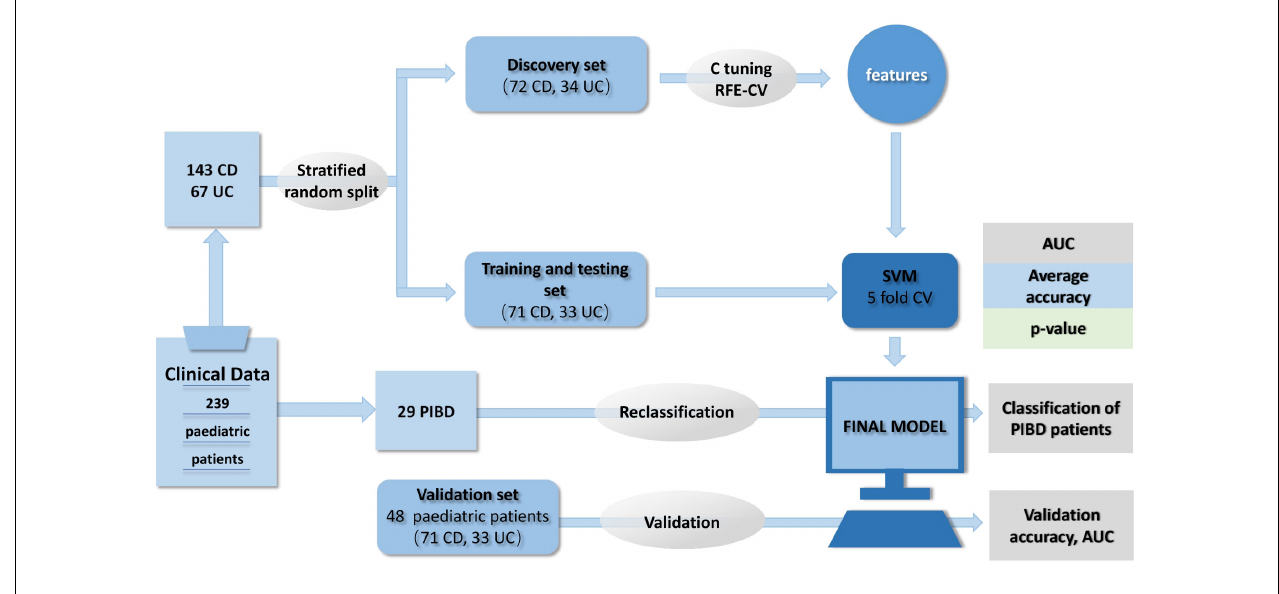
FIGURE 4 | Model construction and data processing. The whole project was composed of model construction, validation, and inflammatory bowel disease unclassified reclassification. The study recruited 239 pediatric patients from the Genetics of Pediatric Inflammatory Bowel Disease study at Southampton Children’s Hospital. The clinical data were used to search the best parameters for classification and train the model. The linear SVM was applied to construct the optimal model, allowing for assessing the relevance with the disease of the selected variable. Then, the optimal penalty parameter (C) tuning and fivefold cross-validation scheme (RFE-CV) help maximizing the classification accuracy by avoiding overfitting. Adapted with permission from Mossotto et al. (2017), Nature Publishing